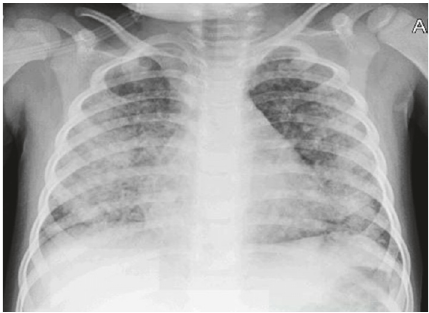
Figure 1: Chest X-ray on initial presentation.